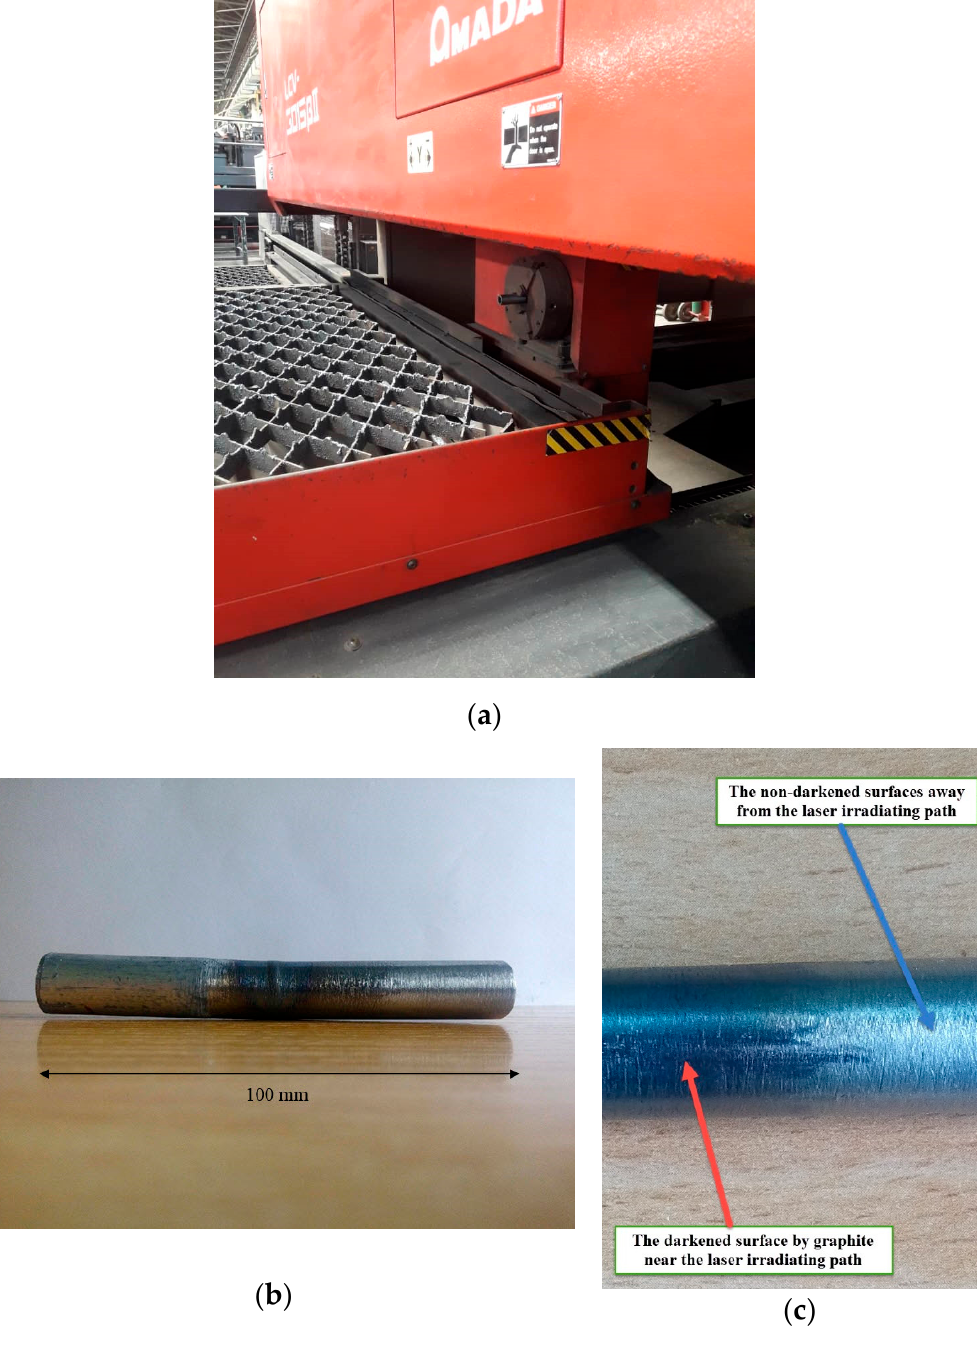
Figure 1. ( a ) The laser machine employed in the laser tube bending experiments; ( b ) a sample of laser-bent tubes in the experimental tests; ( c ) the darkened and non-darkened areas in a laser-bent tube.